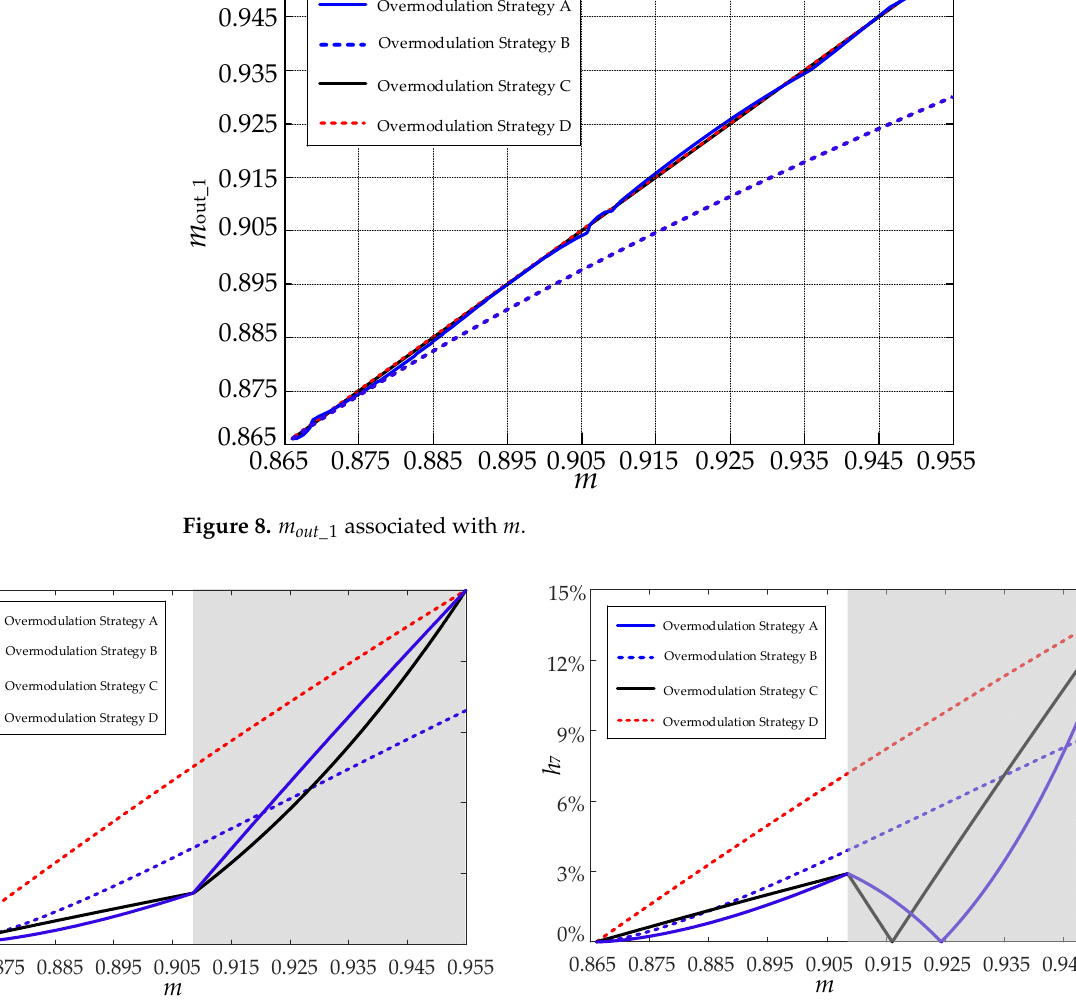
Figure 9. Harmonic components: ( a ) 5th; ( b ) 7th.